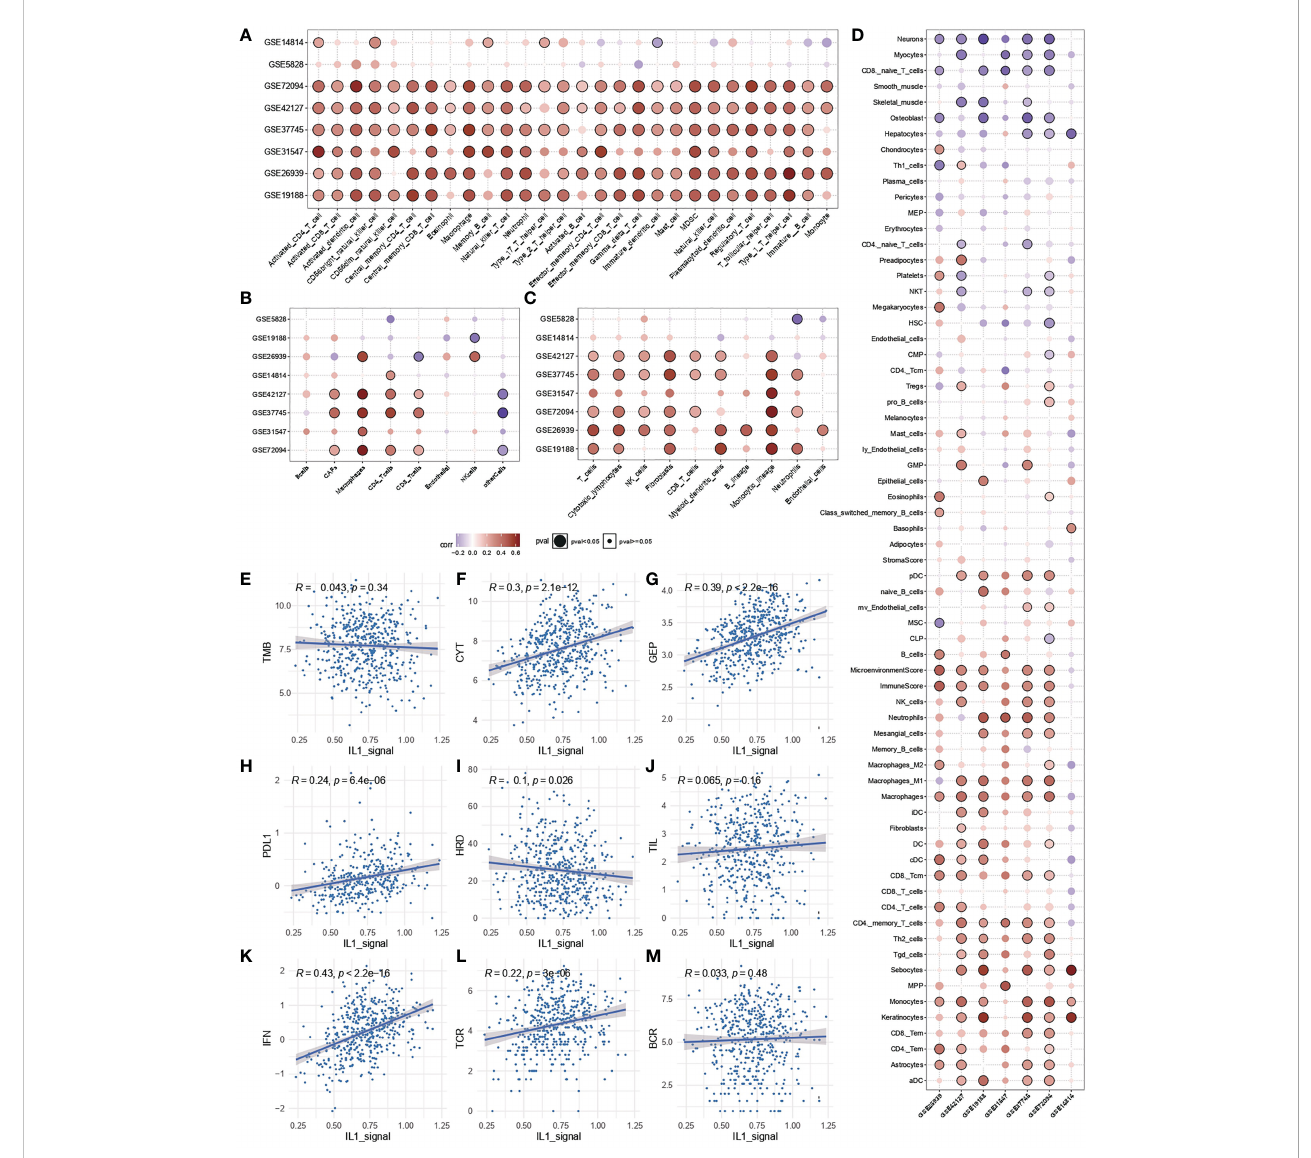
FIGURE 4 Immunological characterisation of IL-1 signalling. (A-C) Correlation of IL-1score with immune function activation in multiple datasets. (D) Correlation of IL-1score with immune cell activation. (E-M) Correlation of IL-score with multiple pan-immune